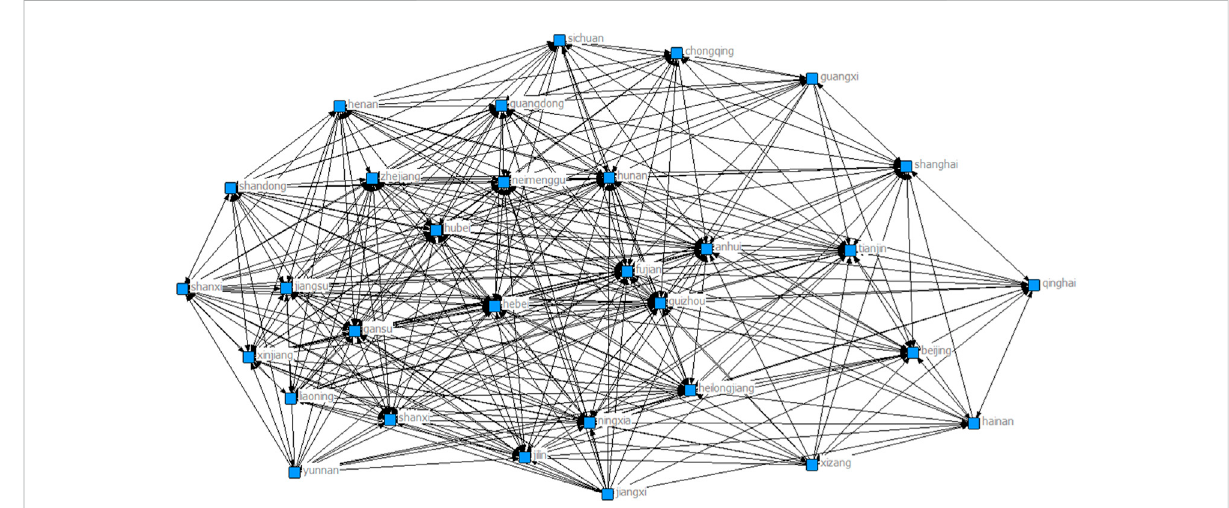
FIGURE 7 Spatial correlation network characteristic of green total factor productivity in service industry.